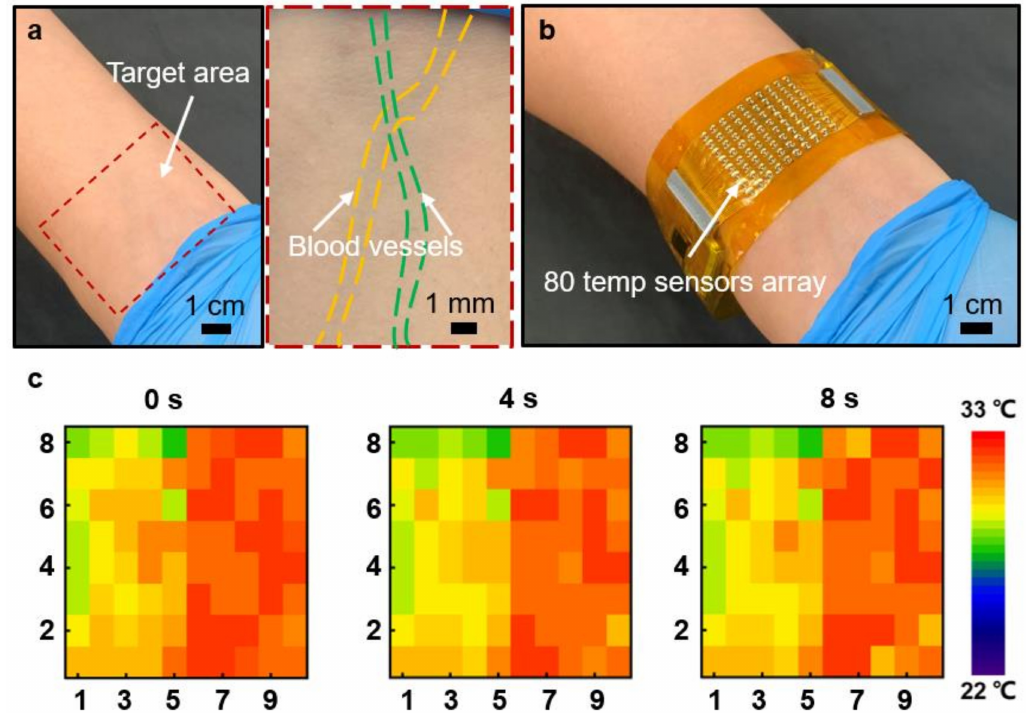
Figure 4. On-body real-time hemodynamic status monitoring. ( a ) Optical images of the target right wrist with the enlarged region showing the traces of the blood vessel. ( b ) Optical image of the WH-sensor attached to the target right wrist during operation. ( c ) Temperature map with the real-time measurements at 0, 4 and 8 s